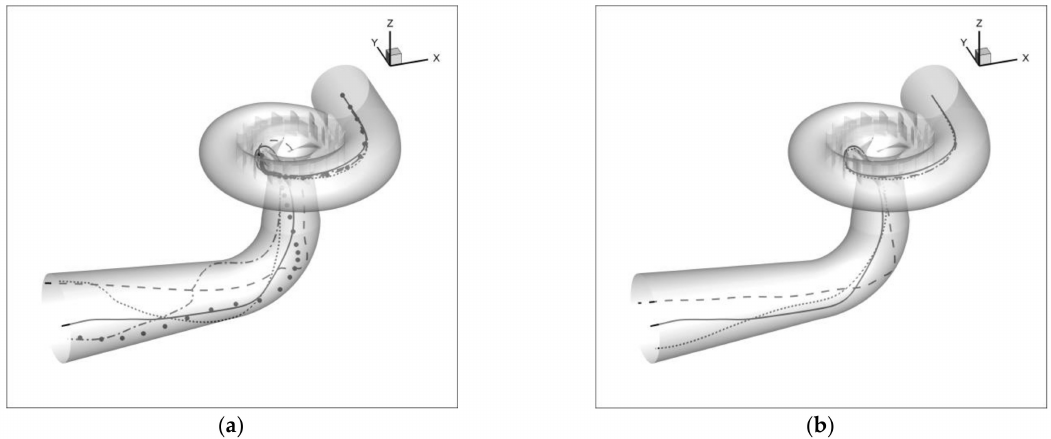
Figure 8. Body trajectories in turbine mode ( a ) Effect of interpolation method: Inverse distance (continuous line), scatteredInterpolant (filled circles), linear regression (dashed line), nearest neigh- bor (dotted line), radial basis functions (dashed-dotted line). ( b ) Effect of resolution: dashed line 500 elements, solid line 1000 elements, dotted line 2000